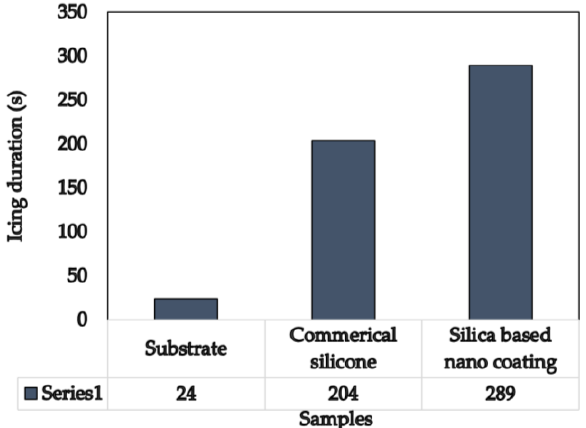
Figure 8. Water droplet icing test results.